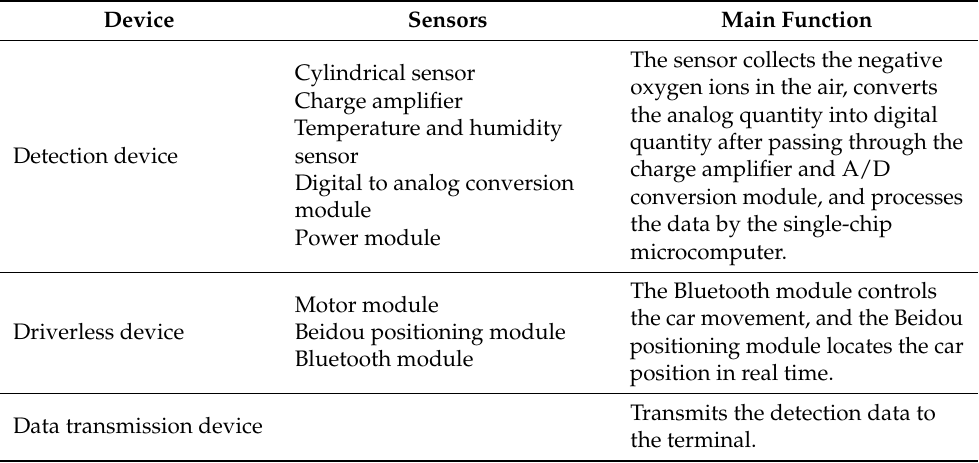
Table 1. Composition and functions of each software and hardware component.